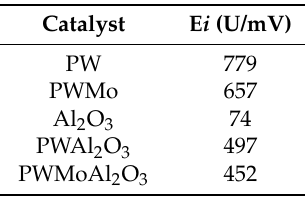
Table 2. Initial electrode potential (E i ) for the catalysts.